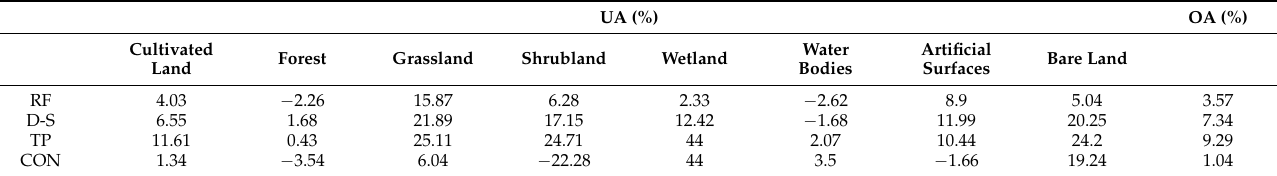
Table 6. Accuracy gains in different fusion products,